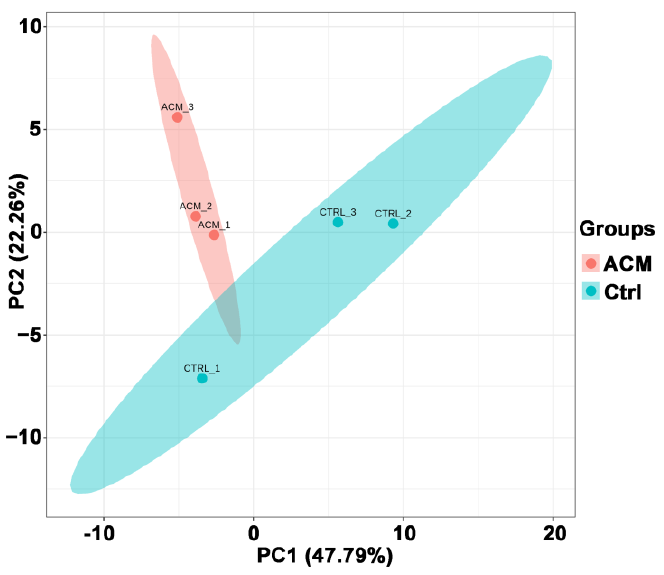
Figure 2. PCA principal component analysis between the control group and the ACM group. Table 2. The up-trend DEPs between the ACM group and the control group.